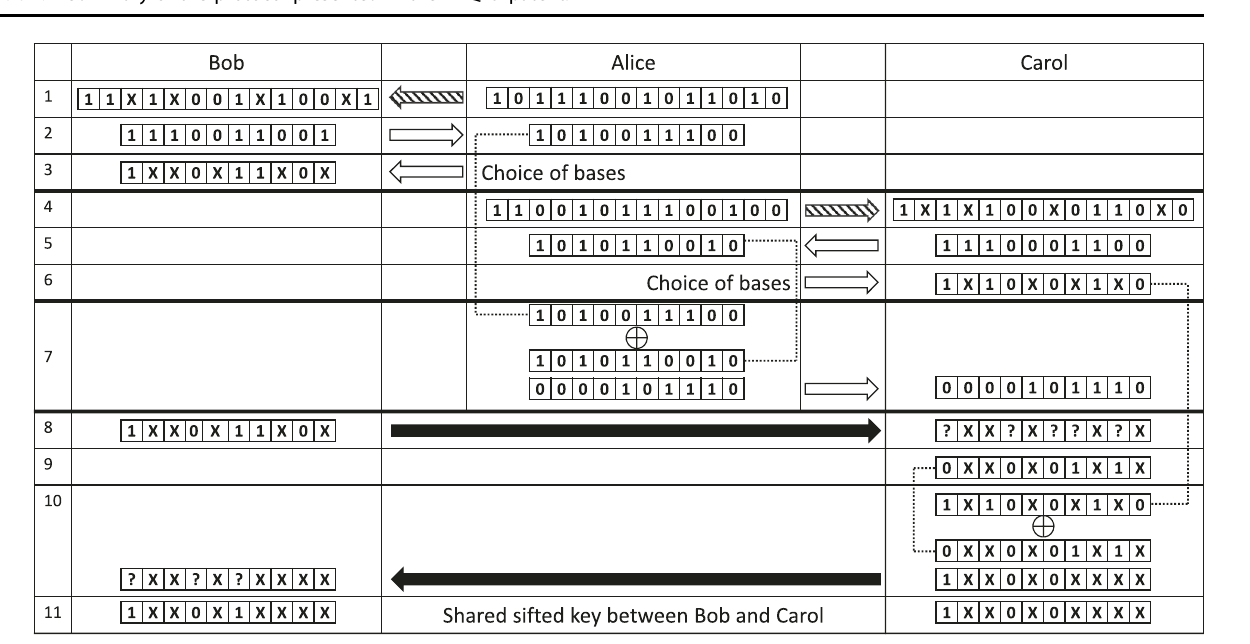
Table 1. Summary of the protocol presented in the ARQ19 patent.